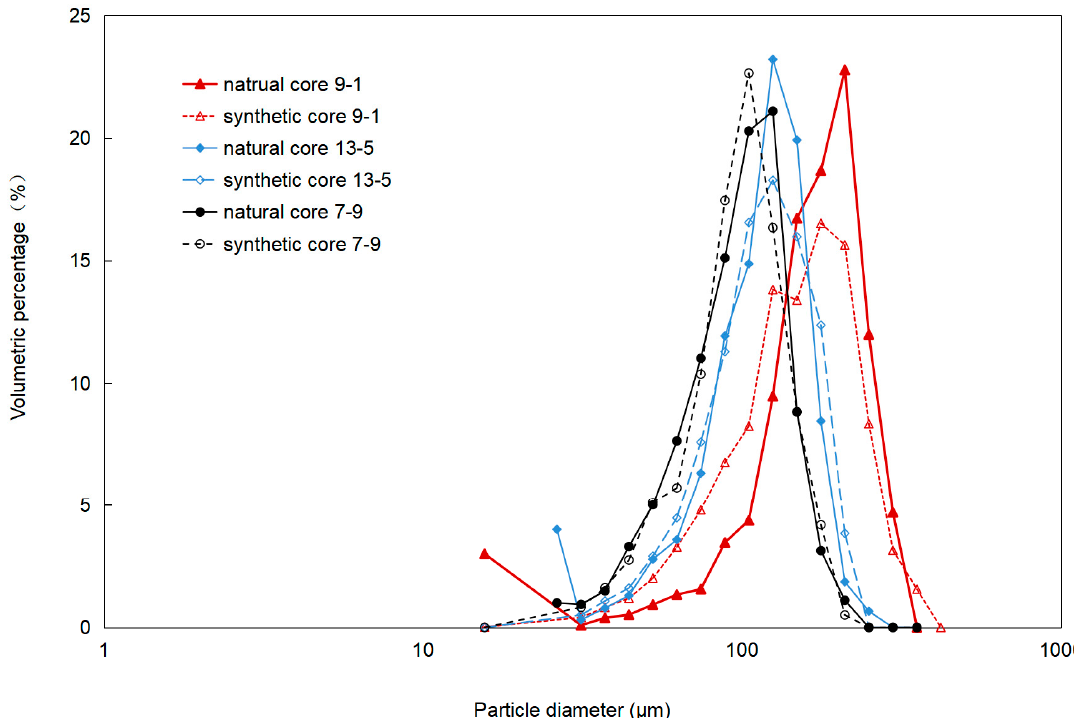
Figure 7. The match of particle size distribution by thin section analysis. The solid lines with ▲ , ♦ , ● are particle size distribution of the target natural cores 9-1, 13-5, and 7-9 respectively by thin section testing. The dotted line with Δ , ◊ , ○ are the particle size distribution of their corresponding synthetic sandstone by thin section testing.